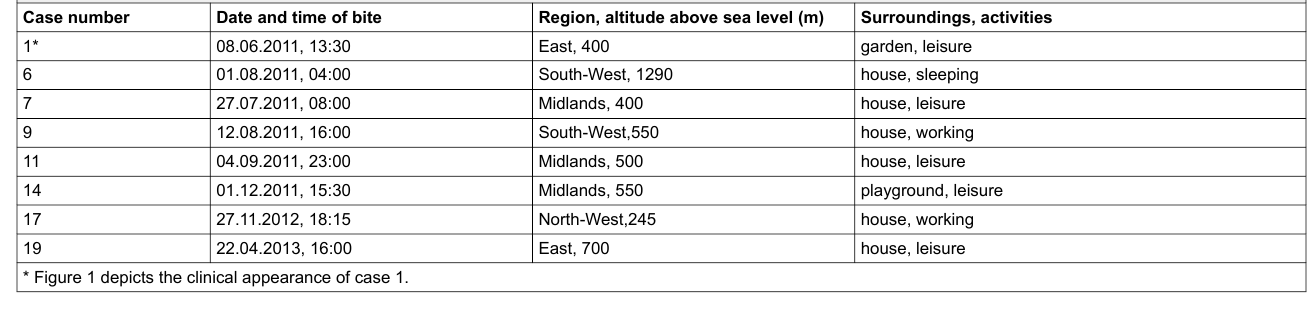
Table 3: Characteristics of spiders involved. Case number